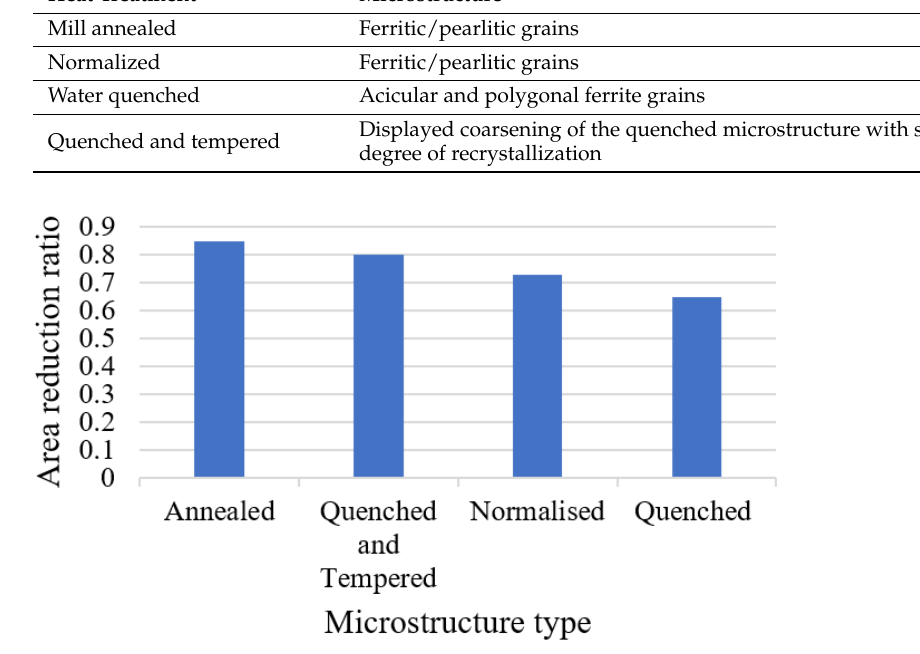
Figure 3. Variations in SCC susceptibility of the different microstructural tested samples. Data from [24].